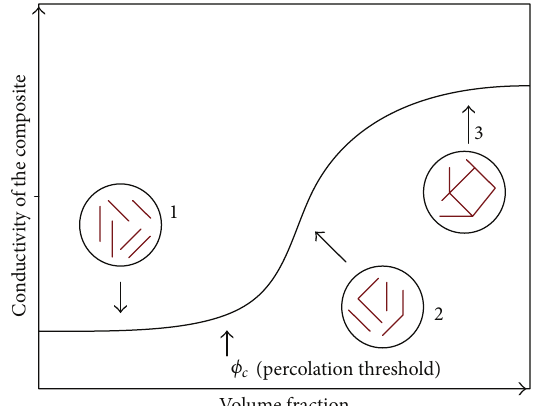
Figure4:DCelectricalconductivityofthenanocompositewhenthe critical exponent of the percolation is varied (Kirkpatrick’s model).